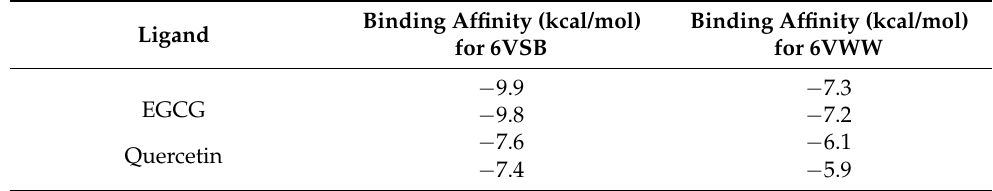
Table 6. The docking results of ADV for EGCG and quercetin toward 6VSB and 6VWW. Only two best modes are presented for each compound (RMSD/L.B: root-mean-square deviation, lower bound; RMSD/U.B: root-mean-square deviation, upper bound).